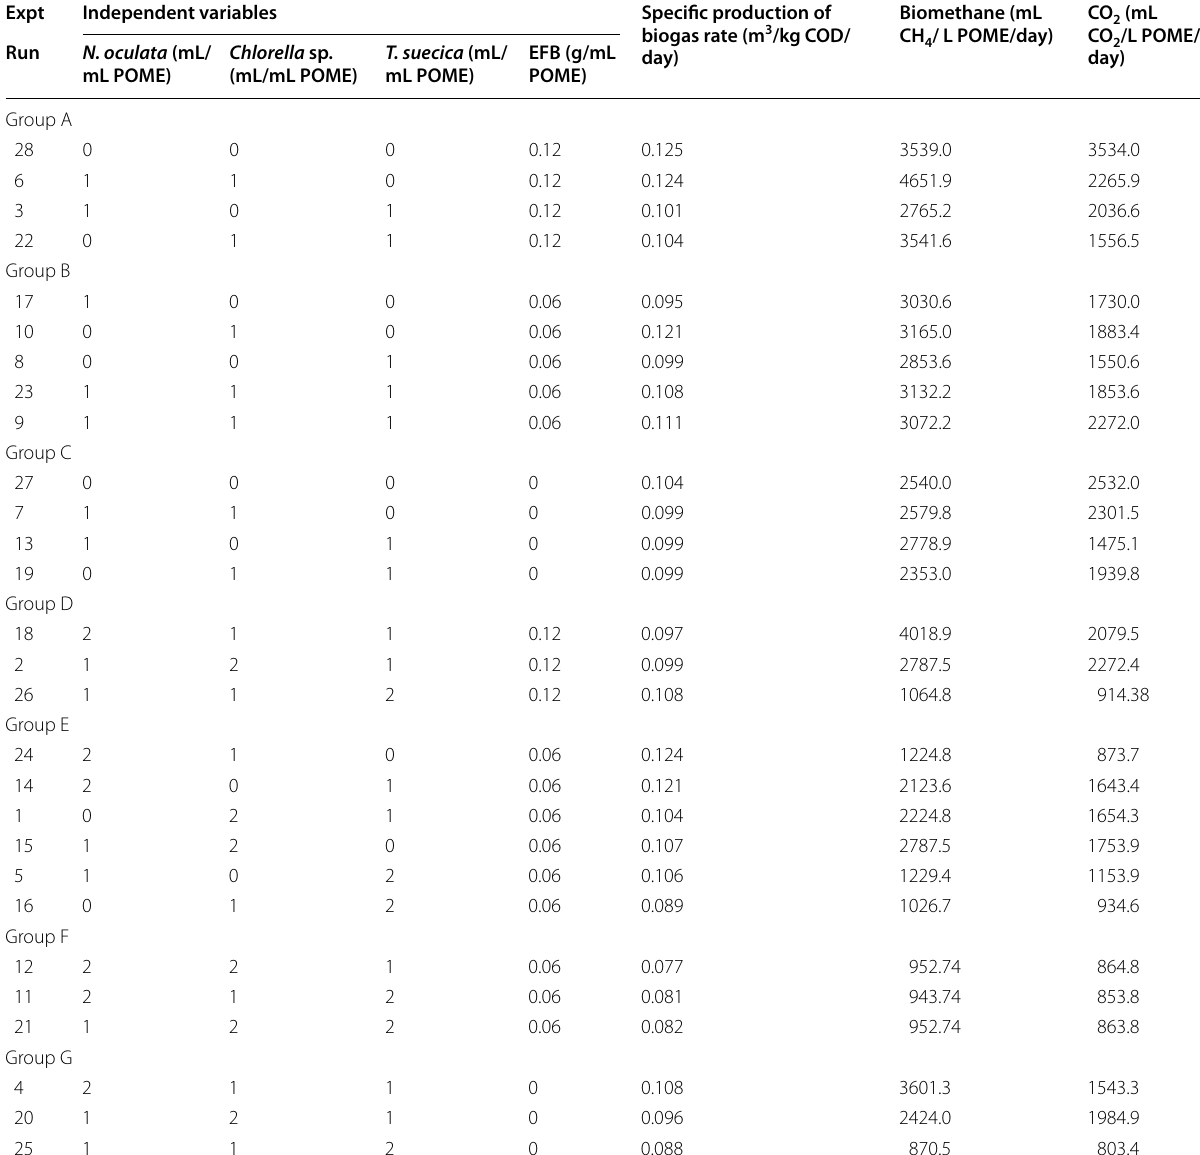
Table 1 Production of biogas from the multi-algal co-digestion with EFB, POME and sludge inoculum (Ahmad et al. 2016) Expt Independent variables Specific production of biogas rate (m 3 /kg